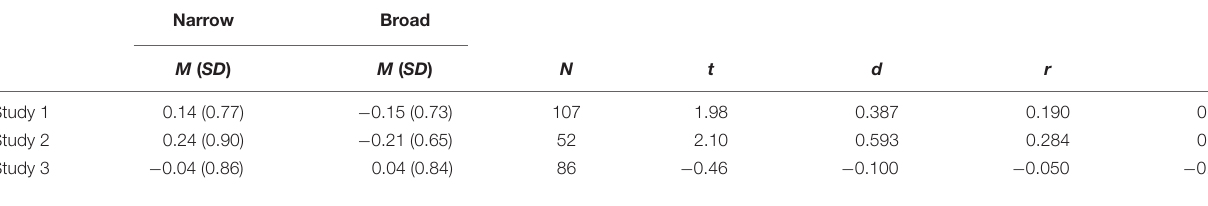
TABLE 10 | Meta-analysis of effect of cognitive scope condition on trait anger/aggression. Narrow